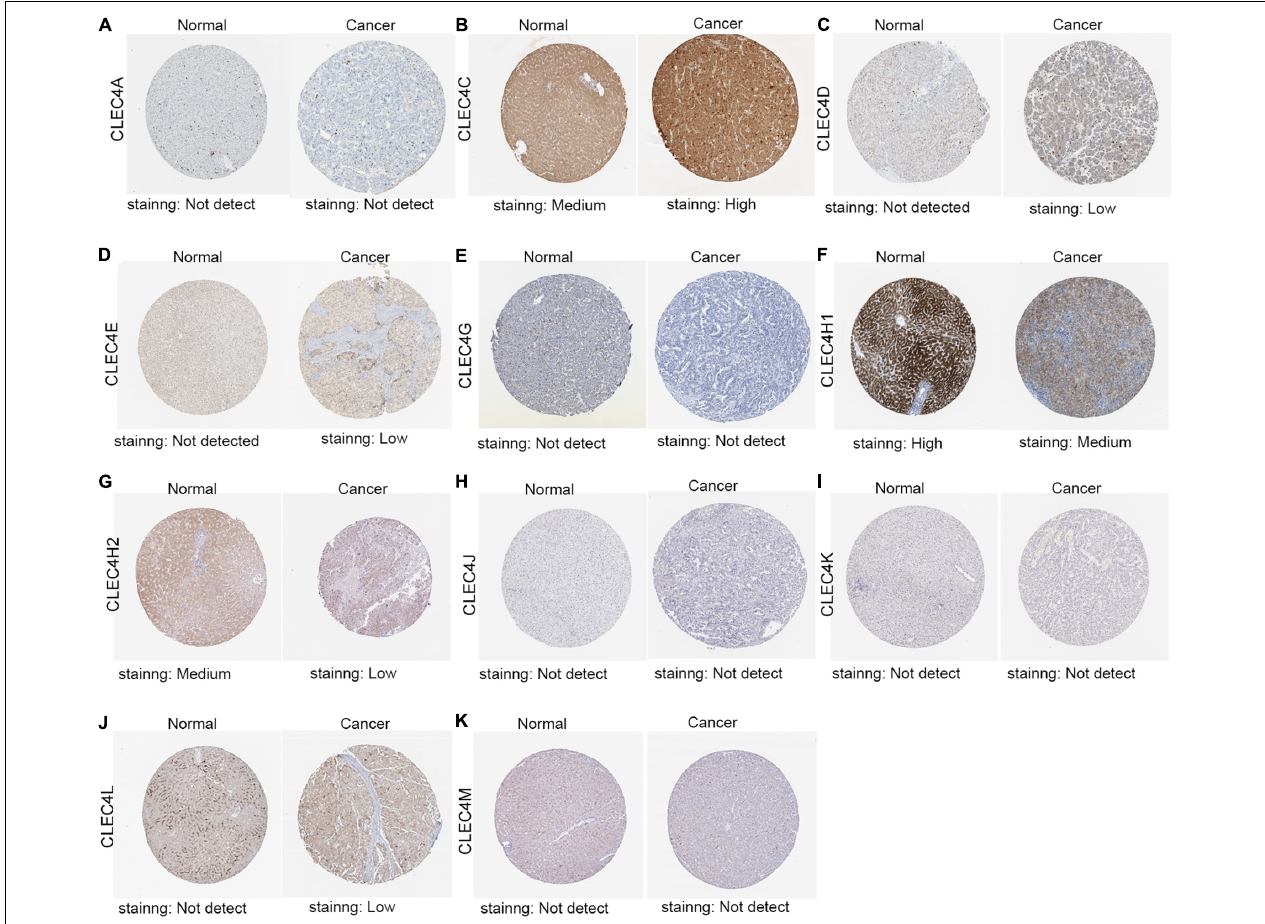
FIGURE 4 | Representative immunohistochemistry images of CLEC4s in HCC tissues and normal liver tissues (Human Protein Atlas). The IHC results showed CLEC4A/G/J/K/M was not detected both in normal and liver cancer tissues (A,E,H,I,K) , while CLEC4C was highly expressed in HCC tissues (B) , CLEC4H1/H2 was lower expressed in HCC tissues compared to normal tissues ( Figures 4F,G ) and CLEC4D/E/L was observed low expression in HCC tissues, but not detected in normal tissues (C,D,J) .